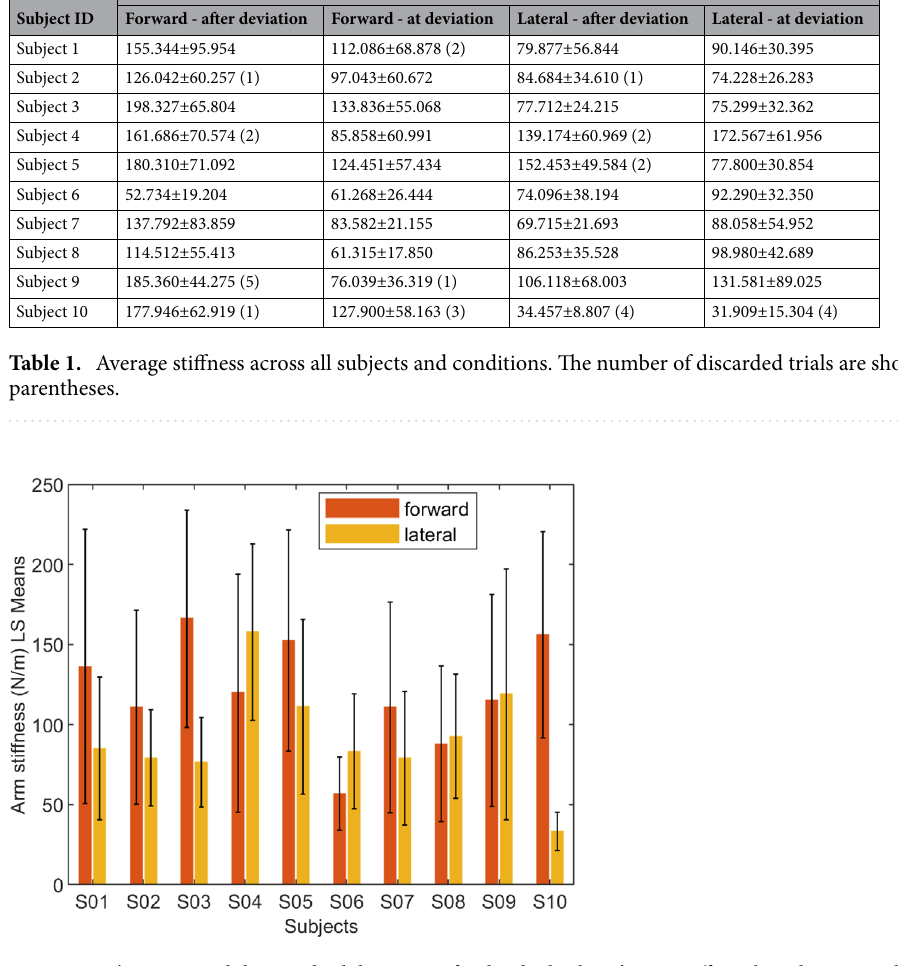
Figure 4. The mean and the standard deviation of individual subject’s arm stiffness based on perturbation direction in both at- and after-deviation conditions.